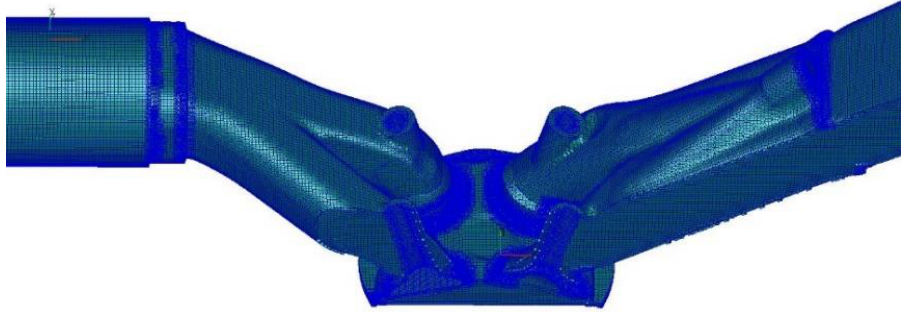
Figure 9. The meshed geometry.